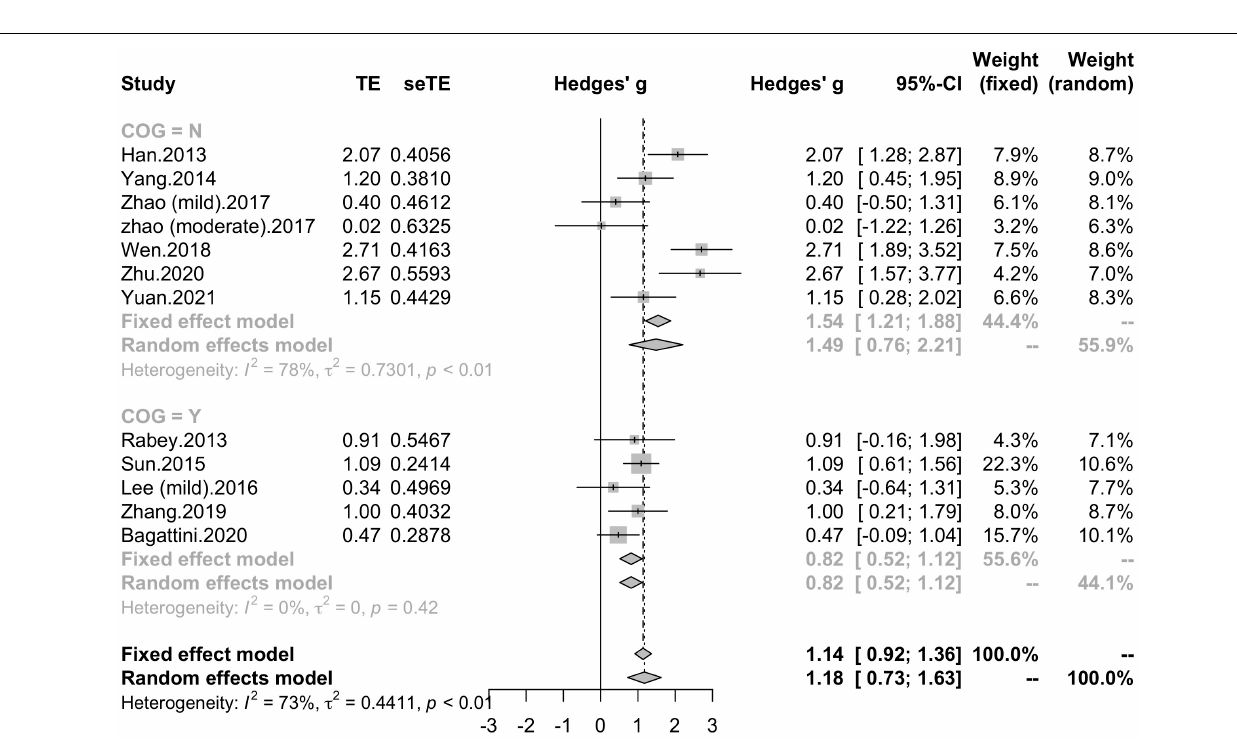
Frontiers in Cell and Developmental Biology |